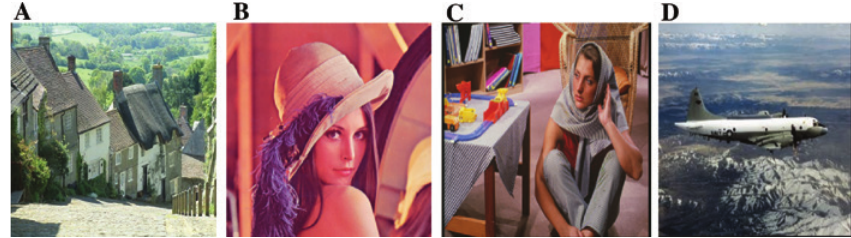
Figure 3: Original Cover Images: (A) Goldhill, (B) Lena, (C) Barbara, (D) Plane.